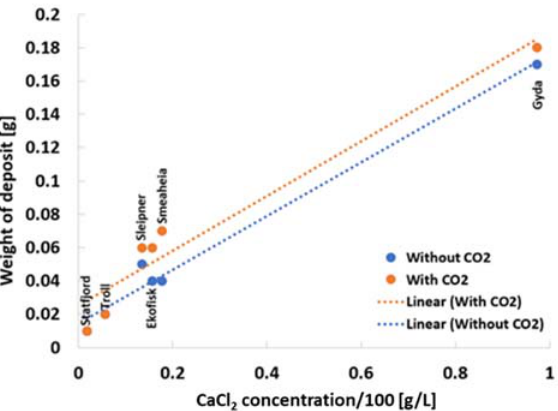
Figure 6. Relation between the concentration of calcium chloride in the solution (formation water) and the total weight of precipitate from 200 mL formation water in the absence and presence of CO 2 .